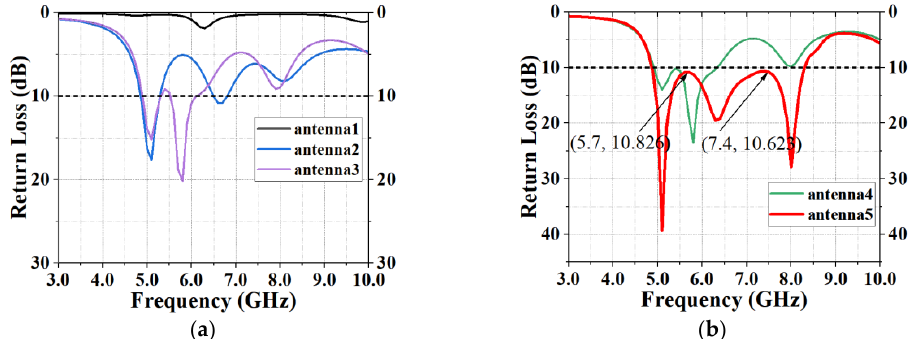
Figure 5. Comparison of return losses of five antennas with different shapes.